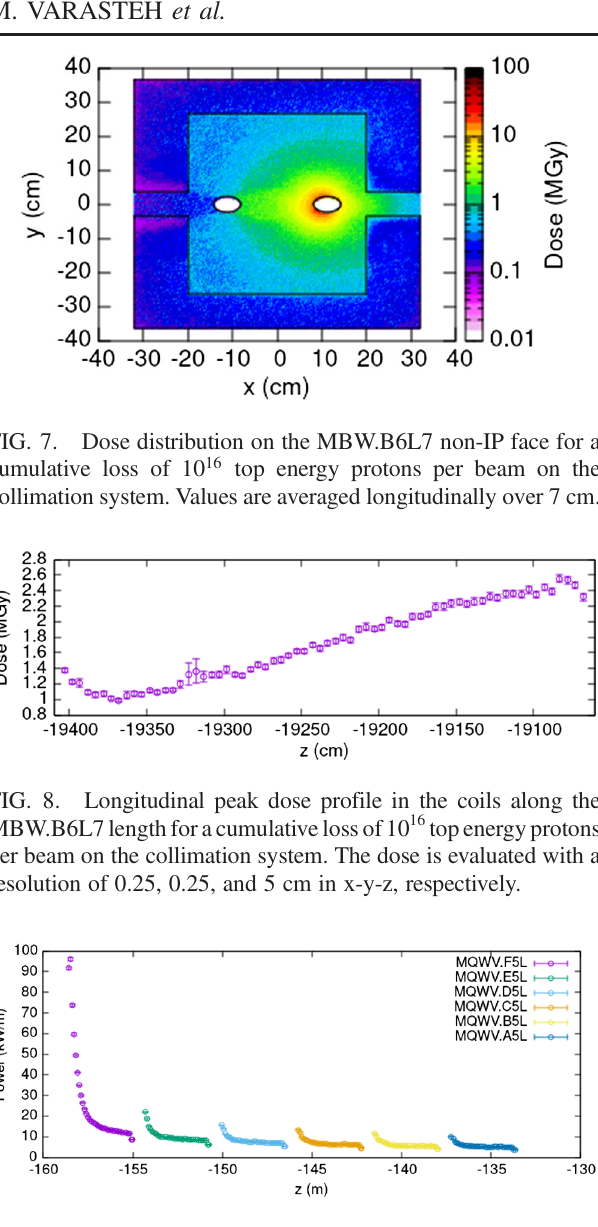
FIG. 9. Absorbed power per unit length in the warm quadru- poles of cell 5L for 0.2 h BLT.